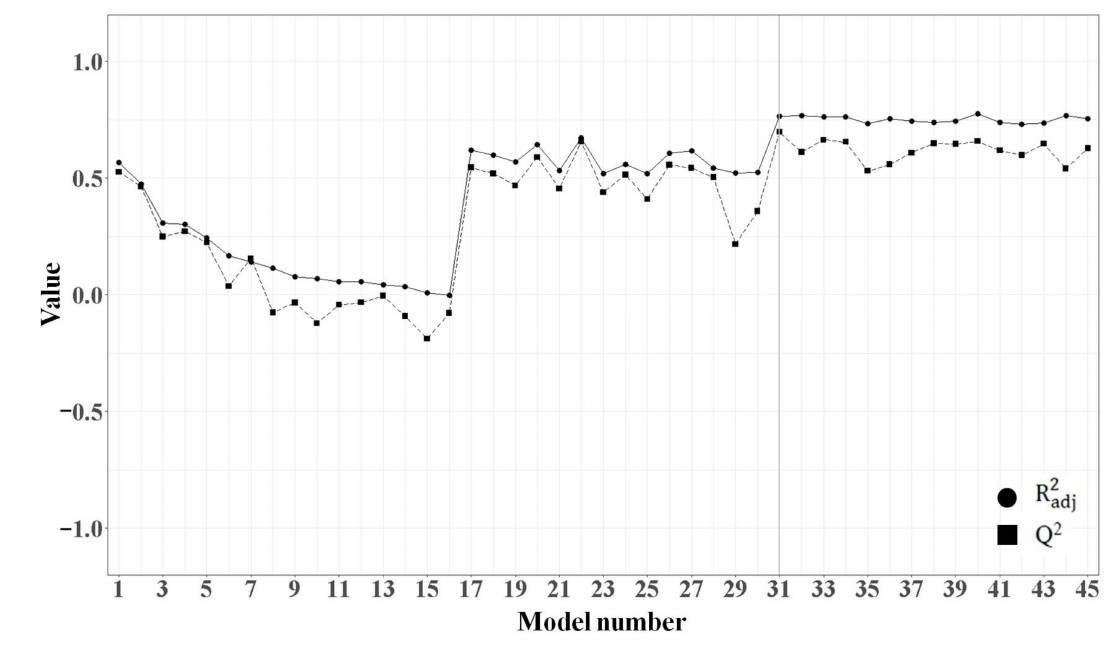
Figure 5. Adjusted R 2 (R 2 ) and Q 2 values of the multiple linear regression (MLR) models created adj using the forward selection method. The performance of 45 models during the forward selection process is expressed as a line